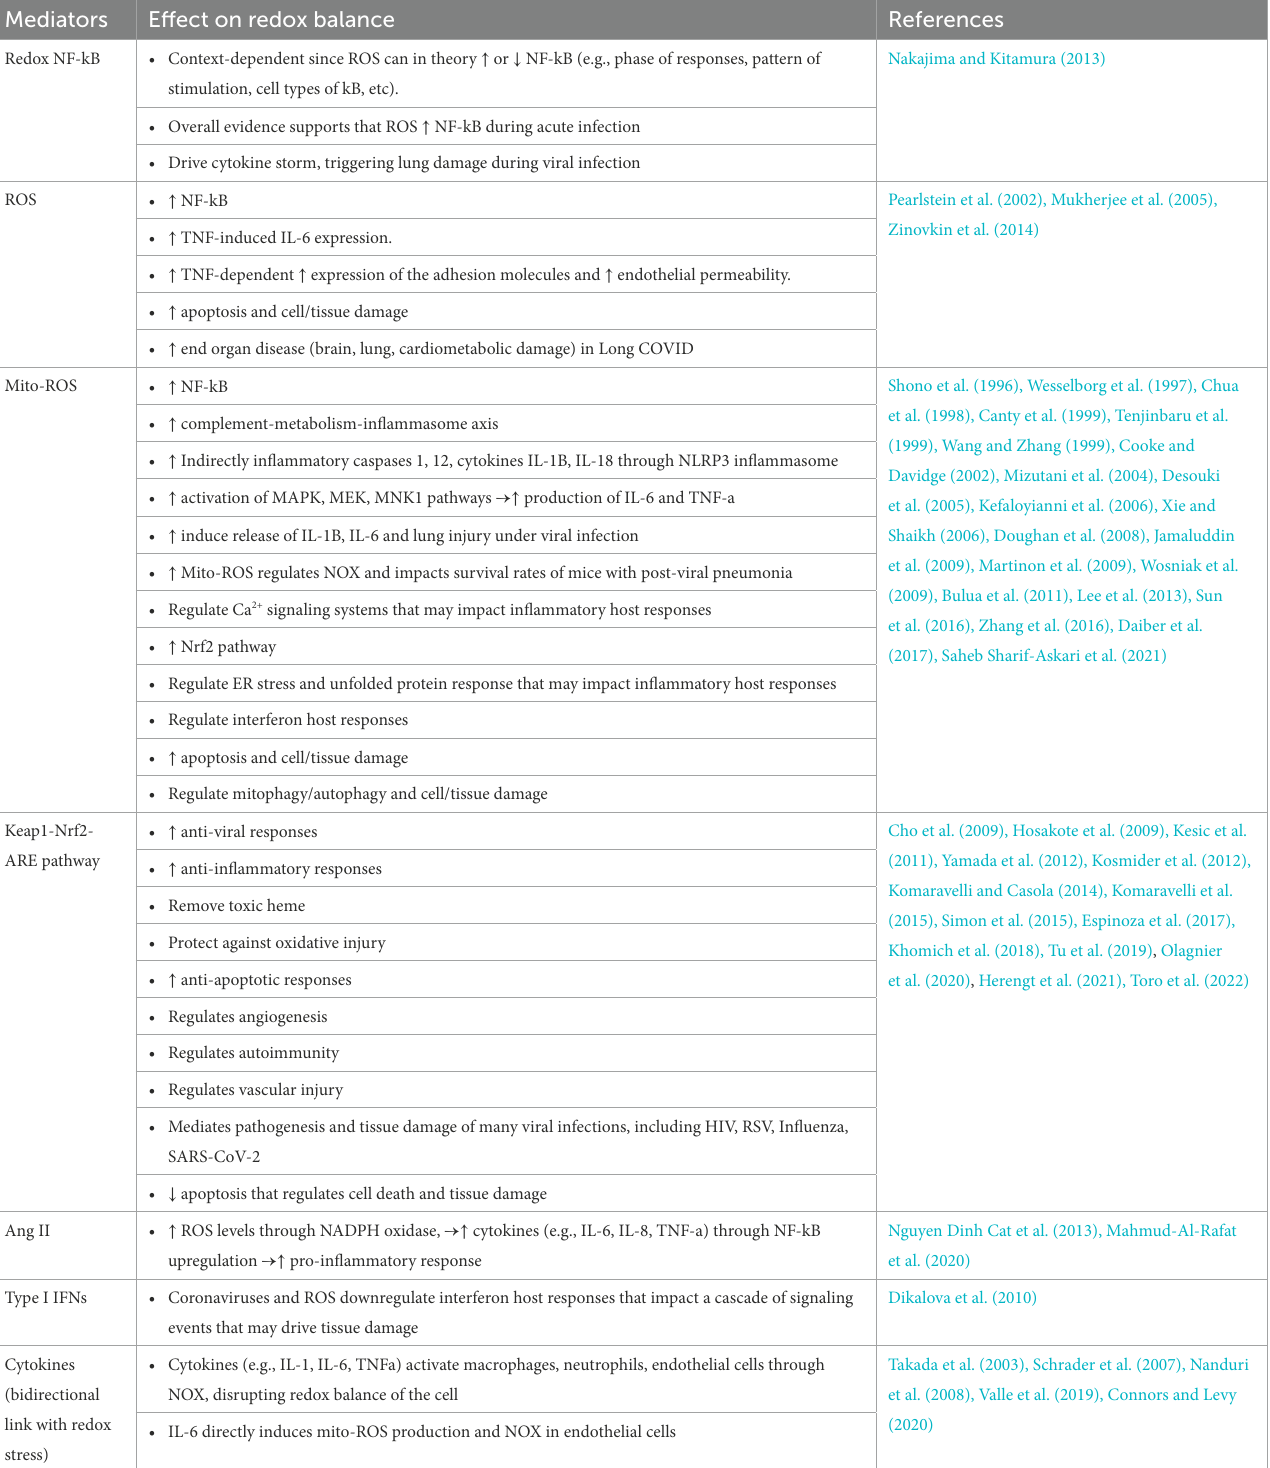
TABLE 2 Redox mechanisms that regulate cell and tissue damage during infection with coronaviruses. Mediators Effect on redox